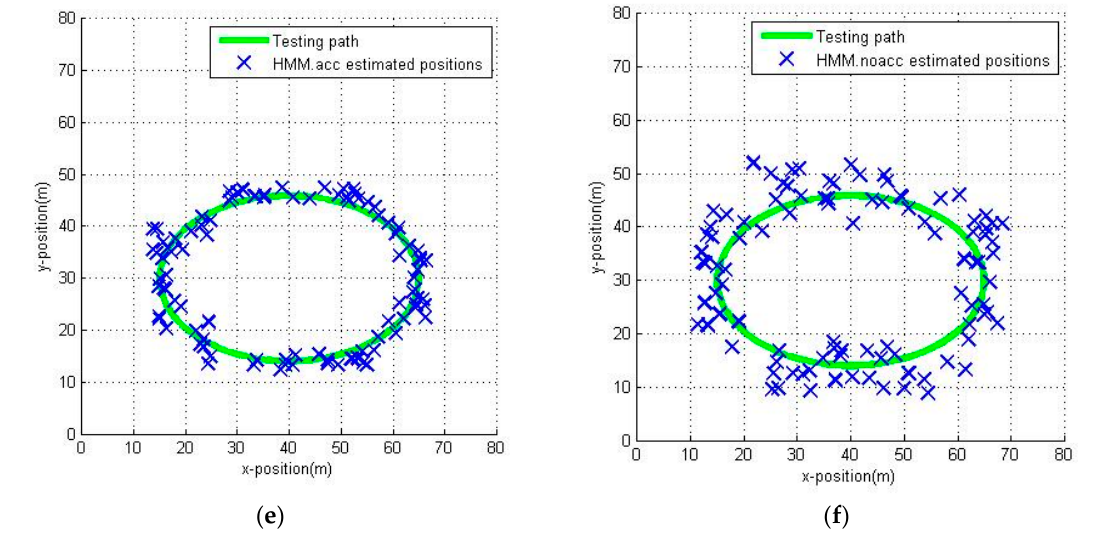
Figure 17. Estimated positions by different positioning methods in the open area: ( a ) KNN; ( b ) PL;